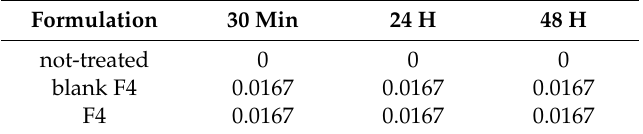
Table 4. Skin irritation index of the blank NLC formulation (blank F4) and the orobol-loaded NLC formulation (F4) at 30 min, 24 h, and 48 h after the topical application to human volunteers for 24